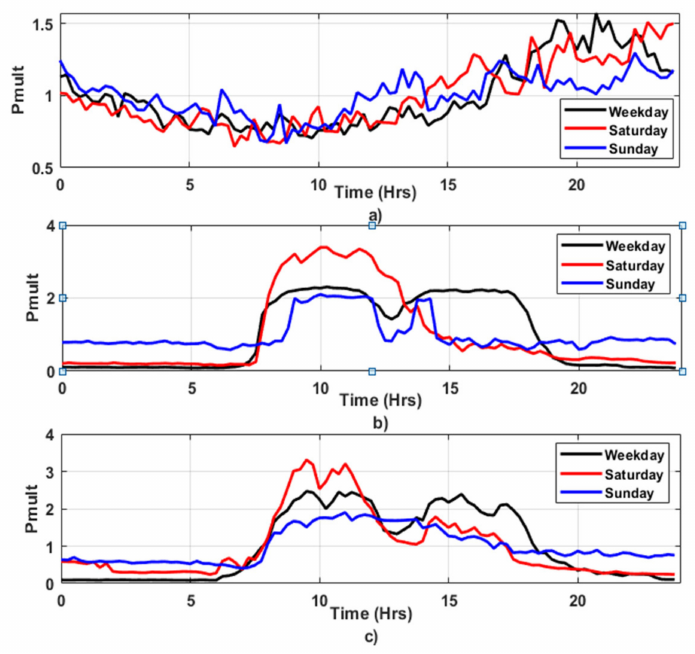
Figure 1. Typical load curves for; ( a ) residential consumer; ( b ) commercial consumer; ( c ) industrial consumer for one business day (black), one Saturday (red) and one Sunday